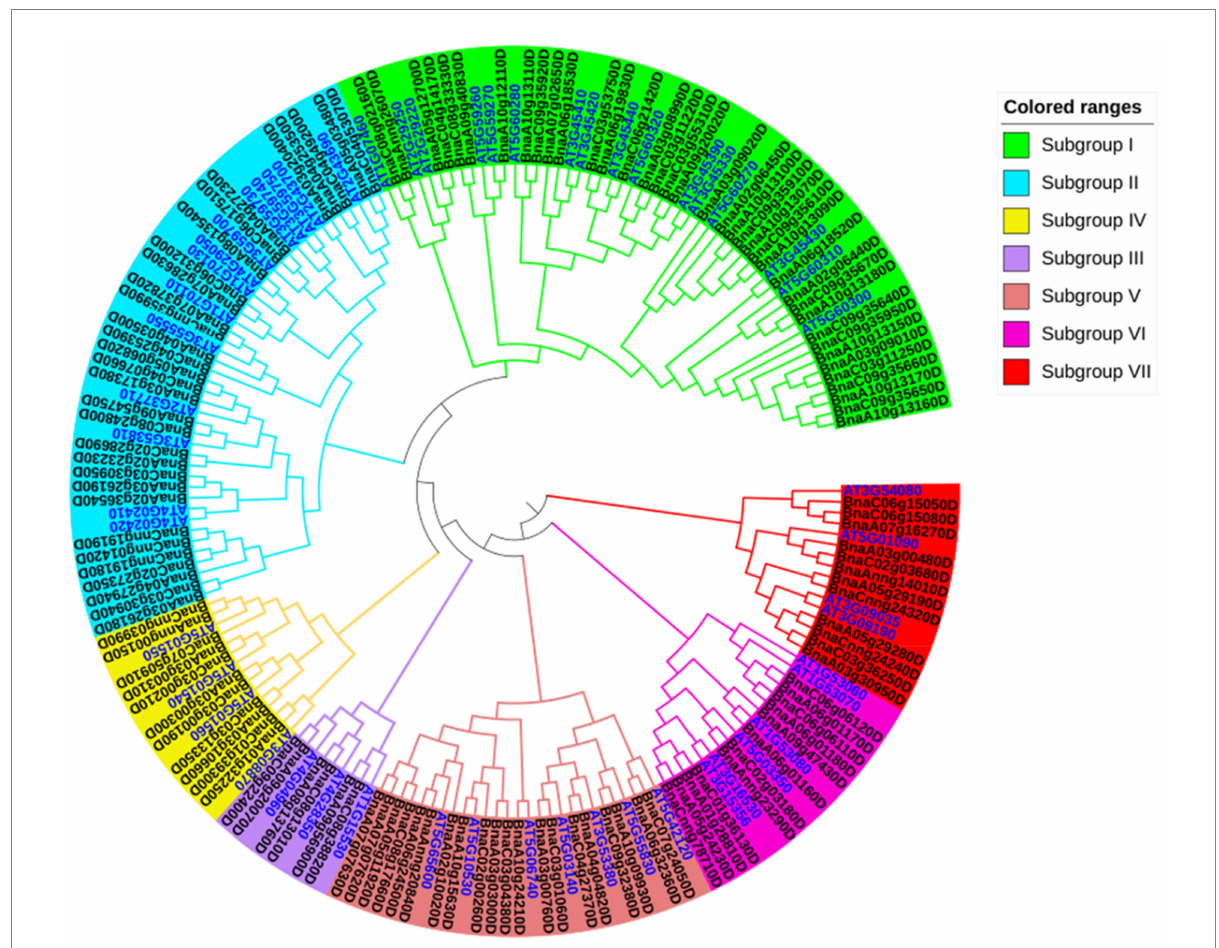
FIGURE 2 Phylogenetic analysis of BnLegLu proteins in A. thaliana and B. napus . All legume lectin proteins were clustered into seven subfamilies (I–VII) with differently colored branches (I, green; II, blue; III, purple; IV, yellow; V, dark red; VI, rose red; VII, red). The gene IDs for B. napus are black, the gene IDs for A. thaliana are bright